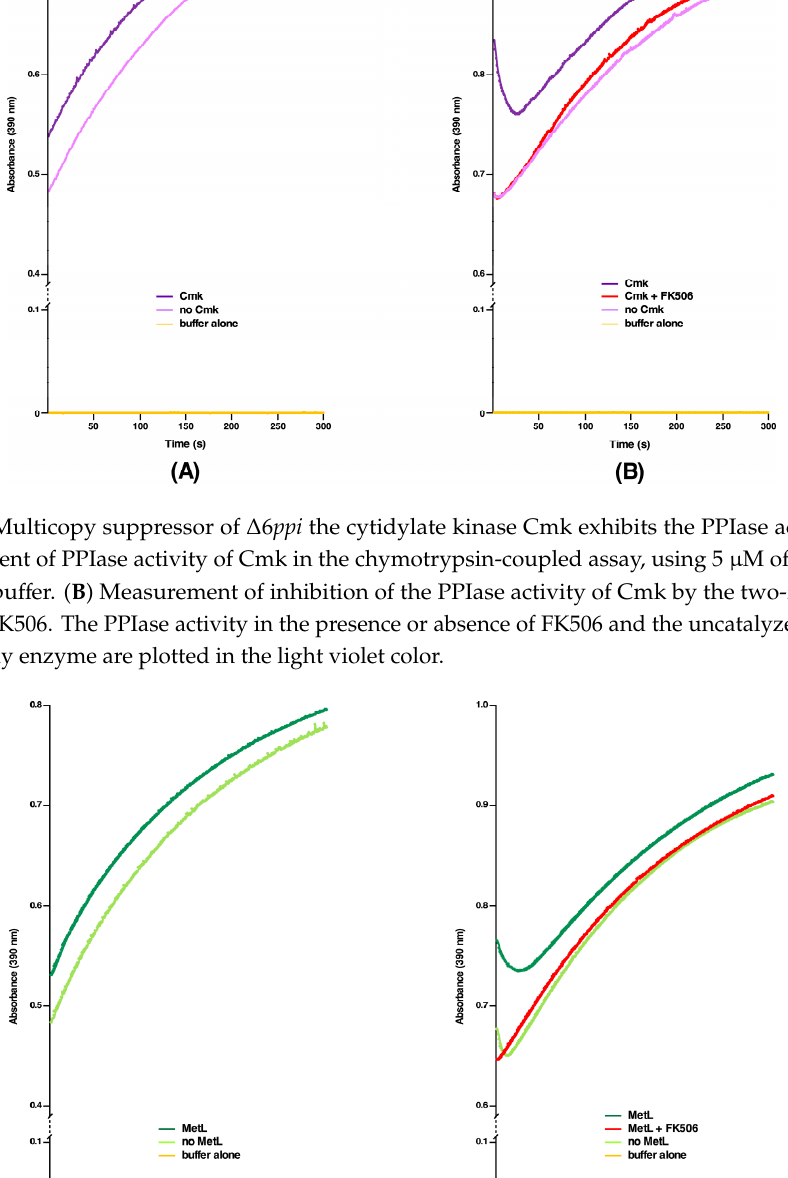
Figure 8. Multicopy suppressor of Δ6 ppi the asparatokinase kinase II MetL exhibits the PPIase activity. ( A ) Measurement of the PPIase activity of MetL in the chymotrypsin-coupled assay, using 5 μM of protein in the assay buffer. ( B ) Measurement of inhibition of the PPIase activity of MetL by the two-fold molar excess of FK506. The PPIase activity in the presence or absence of FK506 and spontaneous reaction without any enzyme are plotted.